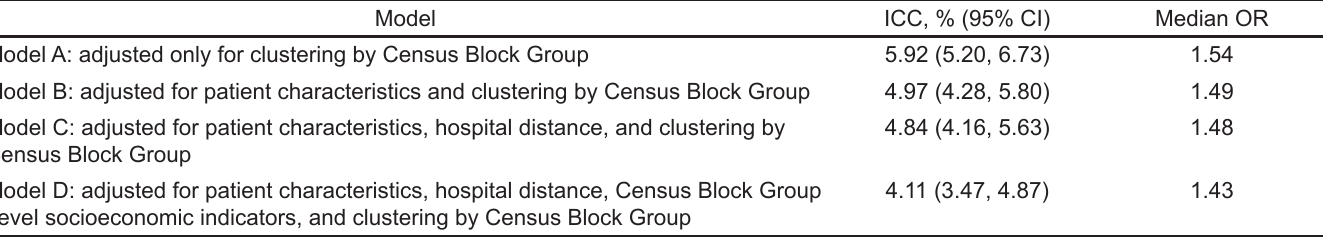
Table 3. Changes in neighborhood-attributable variation in Prevention Quality Indicator visit likelihood by Census Block Group according to multilevel model